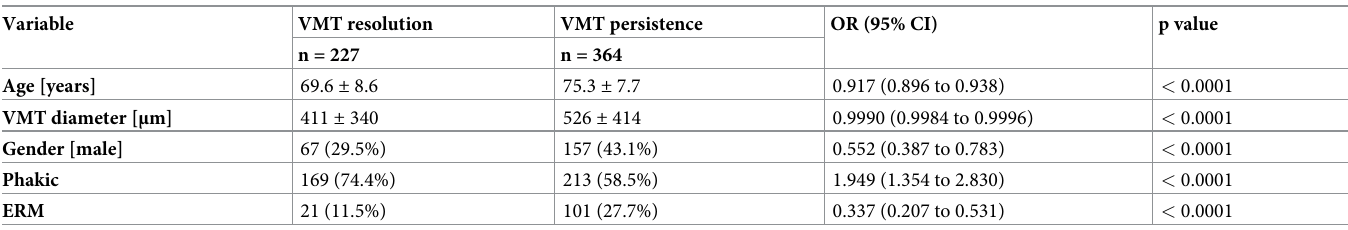
Table 1. Univariate regression analysis results of the analysed variables. Variable